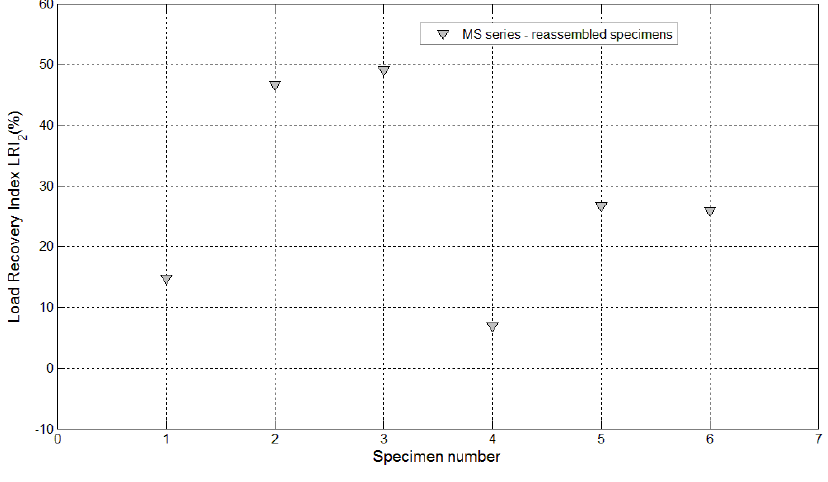
Figure 20. Load recovery indices LRI 2 for specimens with maccheroni tubes (Samples 1–6 belonging to the MS series) reassembled after complete failure and re-loaded after the second self-healing